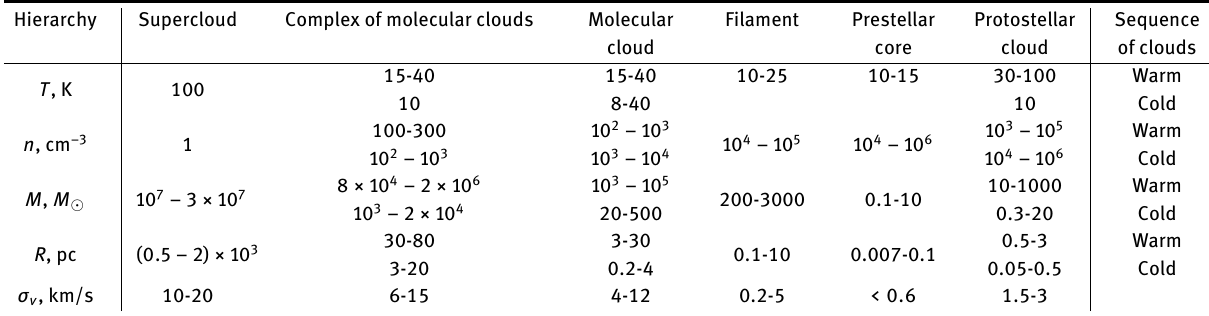
Table 1. The hierarchy of the interstellar magnetic clouds Hierarchy Supercloud Complex of molecular clouds Molecular